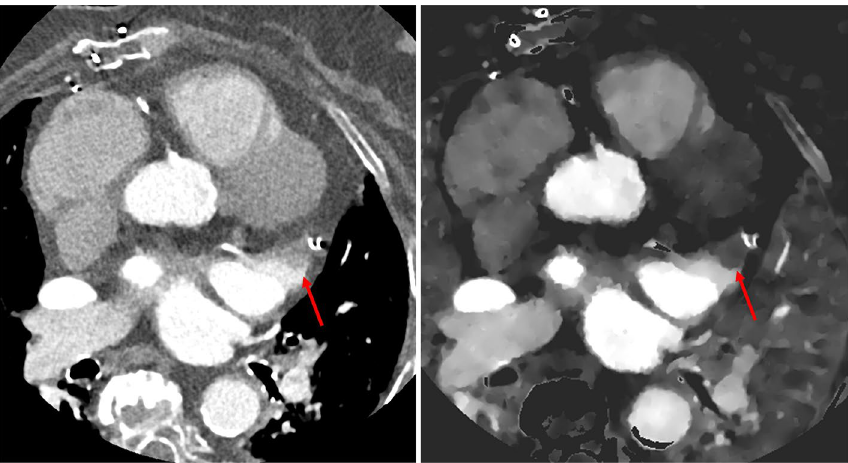
Figure 3. 9 mm thrombus in the left atrial appendage, which was missed on conventional cardiac CT images (left). The finding was classified as circulatory stasis. The thrombus was diagnosed on iodine density reconstructions